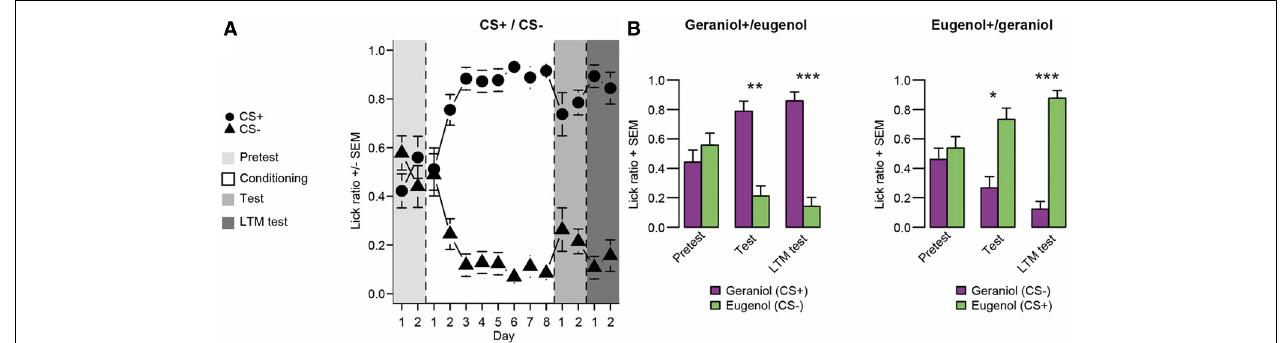
FIGURE 2 | Experiment 1: Tests for conditioned odor preference induced in the two groups of rats after conditioning and one month later. (A) Learning curve and test followed by long-term memory test (LTM test) performances for the two groups pooled ( n = 16). During the conditioning period, the CS + odor was associated with the sucrose solution and the CS- with plain water. Before and after conditioning (pretest and tests), both odors